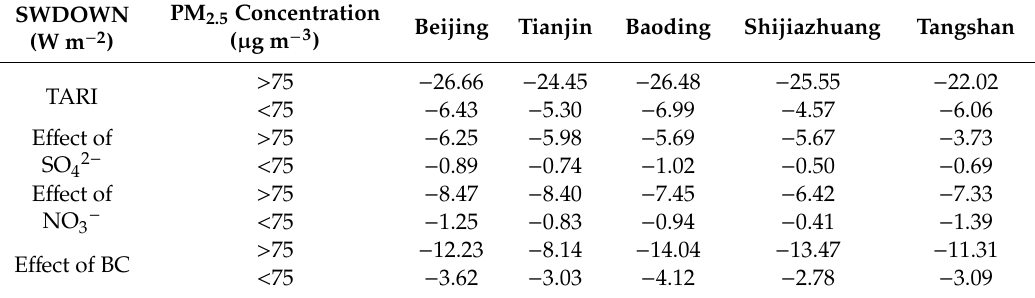
Figure 6. Simulated results of ARI effects for different particulate matter components on SWDOWN. Table 4. The effects on SWDOWN under different PM 2.5 pollution levels.